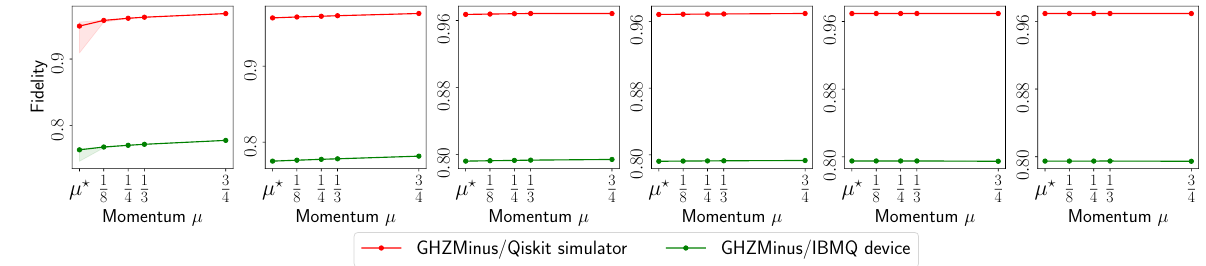
Figure A11. Convergence iteration plots for reconstructing GHZ ments from IBM Quantum system experiments and synthetic measurements from Qiskit simula- tion experiments.